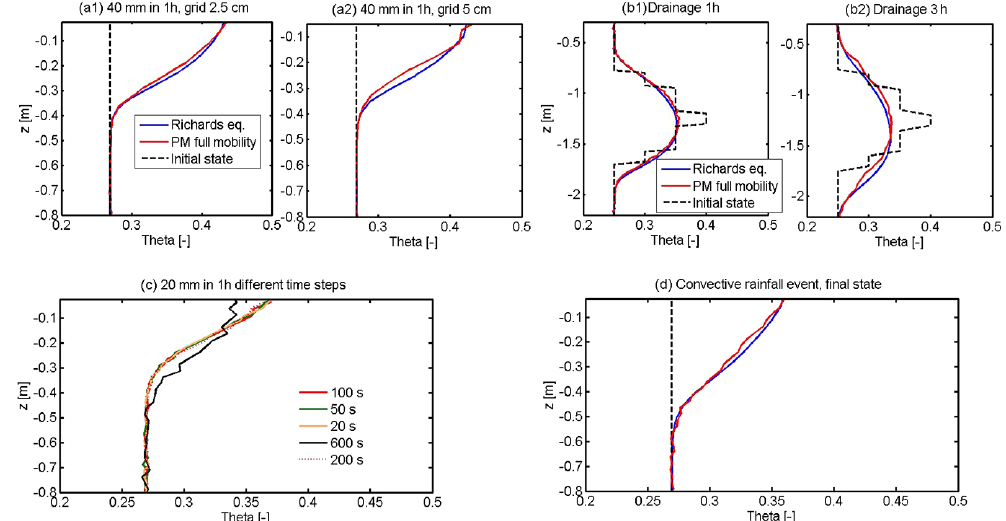
Figure 3. Final soil moisture profiles simulated for the sandy soil with the full mobility model for a block rain of 40mm at two different grid sizes ( a1 and a2 ); the drainage experiment starting from the bell-shaped initial state ( b1 and b2 ), for a block rain of 20mm at different time steps (c) ; and the convective rainfall event (d) .